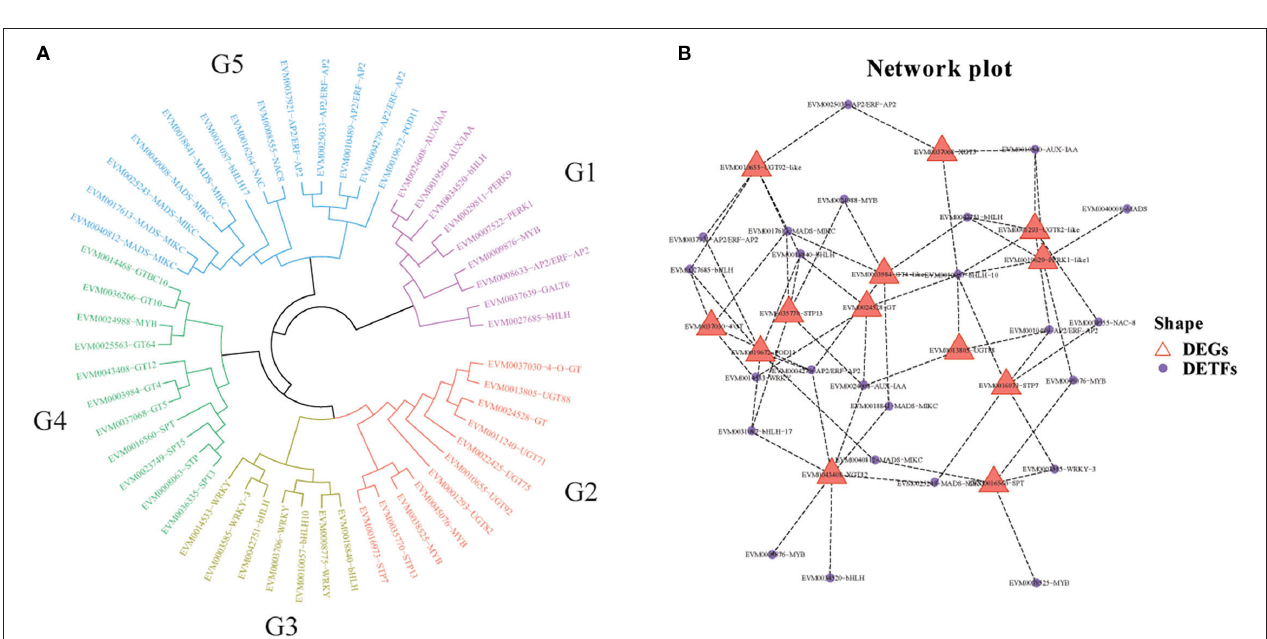
encoded UDP-glycosyltransferase, sugar transport